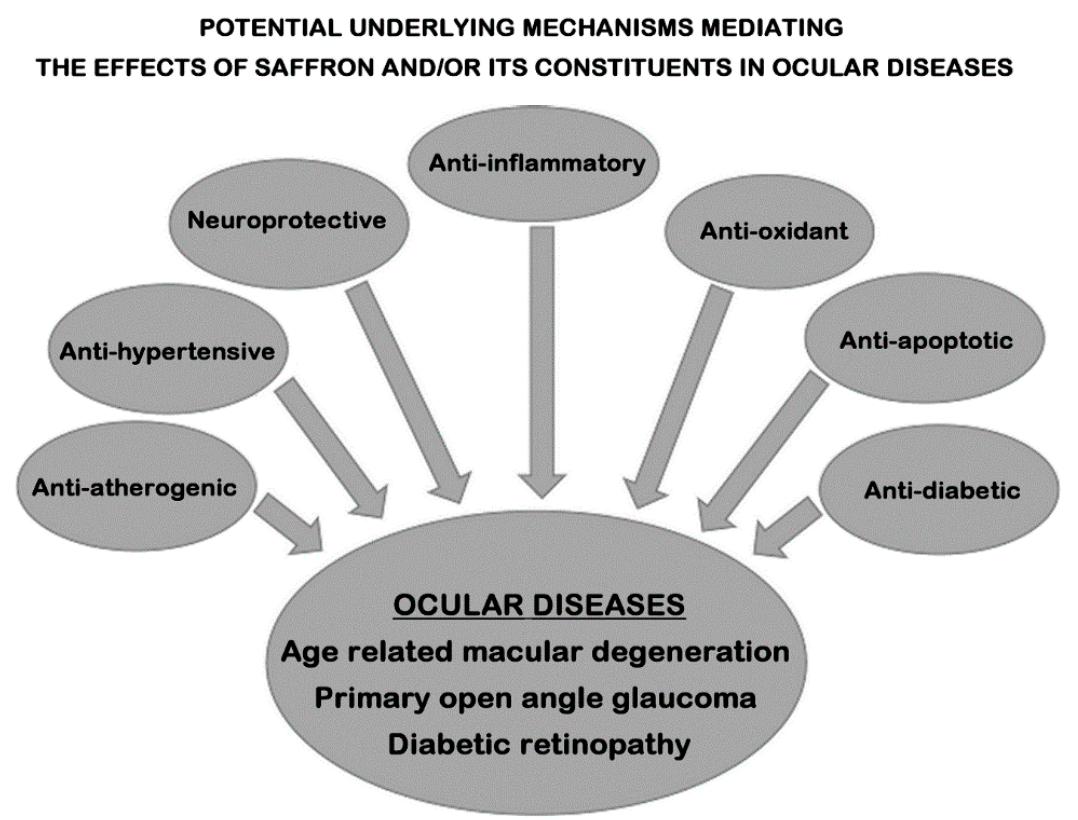
Figure 1. Simplified schematic representation of the potential mechanisms that may mediate the effects of saffron and/or its constituents (e.g., crocin) in various ocular diseases (e.g., age related macular degeneration, primary open angle glaucoma, and diabetic retinopathy), including anti-inflammatory, anti-oxidant, anti-apoptotic, neuroprotective, antidiabetic, anti-atherogenic, and anti-hypertensive effects.